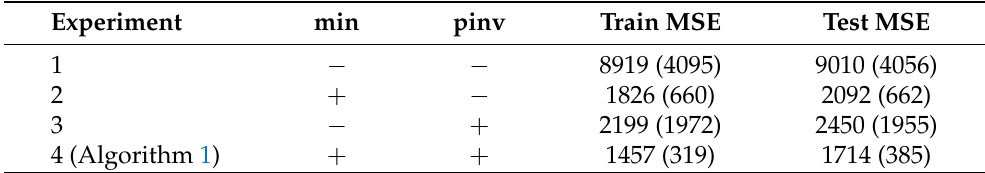
Table 5. Ablation experiments. Average MSEs (with std) obtained on the bike-sharing dataset by the ANMIN Algorithm 1 with different parts